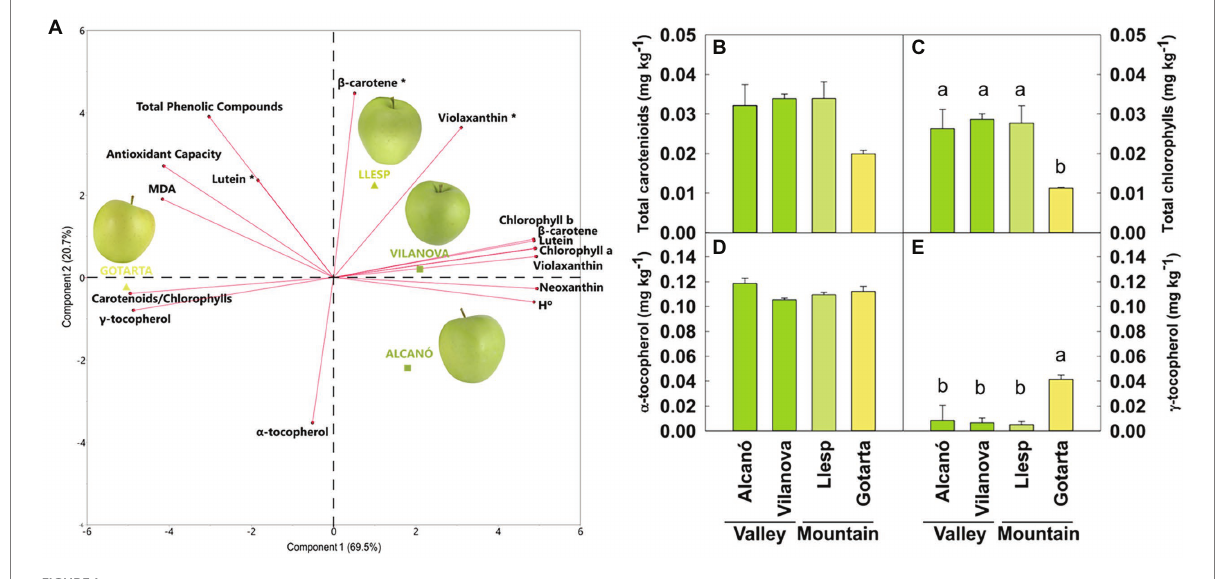
FIGURE 1 Principal component analysis (PCA) characterization of the apple peel from four different locations (two orchards from the valley: Alcanó and Vilanova; and two orchards from the mountain: Llesp and Gotarta) using 16 variables including Hue angle (H ° ) individual pigments and tocopherols, antioxidant capacity, TPC and MDA (A) . Total carotenoids (B) , total chlorophylls (C) , α -tocopherol (D) , and γ -tocopherol (E) in the peel of apples grown in different locations. Error bars represent the standard error ( n = 4). Letters, whenever available, indicate significant differences between